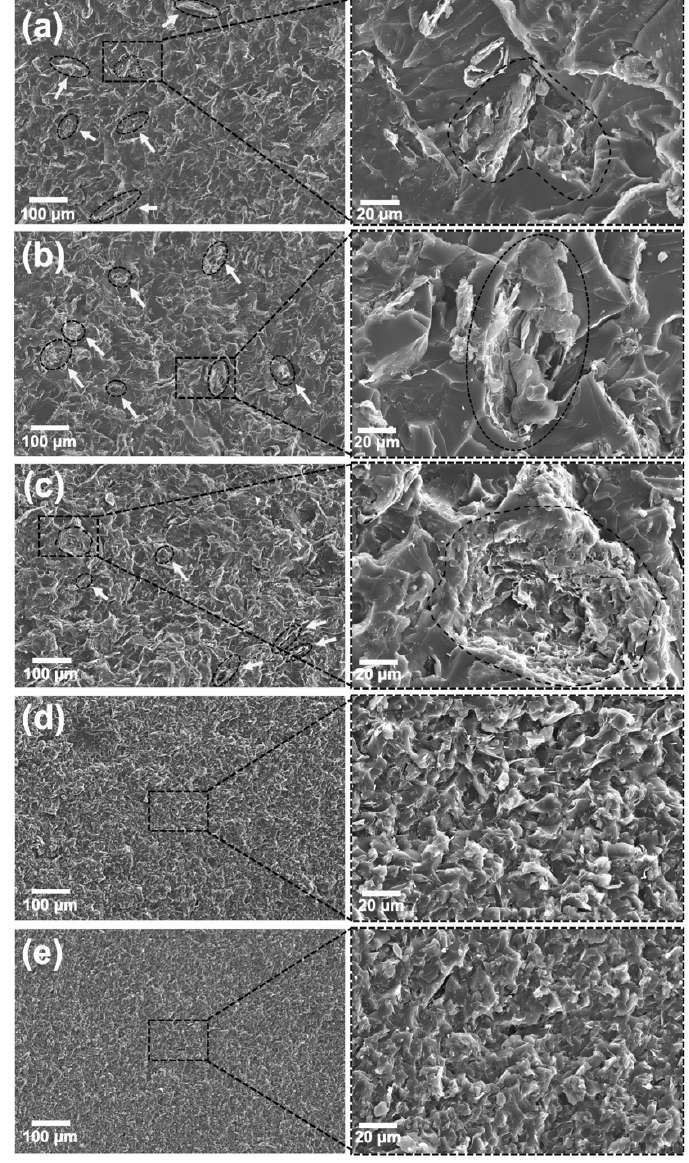
Figure 10. ( a ) SEM images of hybrid nanocomposites loaded with 2.5 wt. % of GNP and 0.25 wt. % of CNT, prepared without sonication; ( b ) with indirect sonication for 120 min; ( c ) with direct sonication for 60 min at 25% amplitude; ( d ) 50% amplitude; ( e ) and 75% amplitude. GNP agglomerates are highlighted.